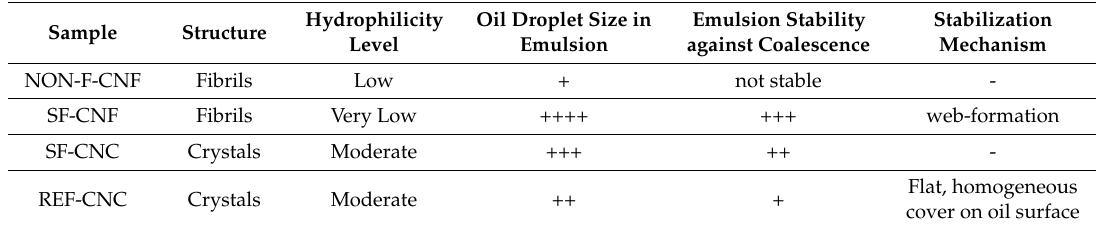
Table 3. CNC and CNF sample characteristics and performance in emulsion stabilization. The scale starts at the lowest/poorest performance (+) and moves up to very good performance (++++). Hydrophilicity Oil Droplet Size in Emulsion Stability Stabilization Sample Structure Level Emulsion against Coalescence Mechanism NON-F-CNF Fibrils Low + not stable - web-formation Flat, homogeneous cover on oil